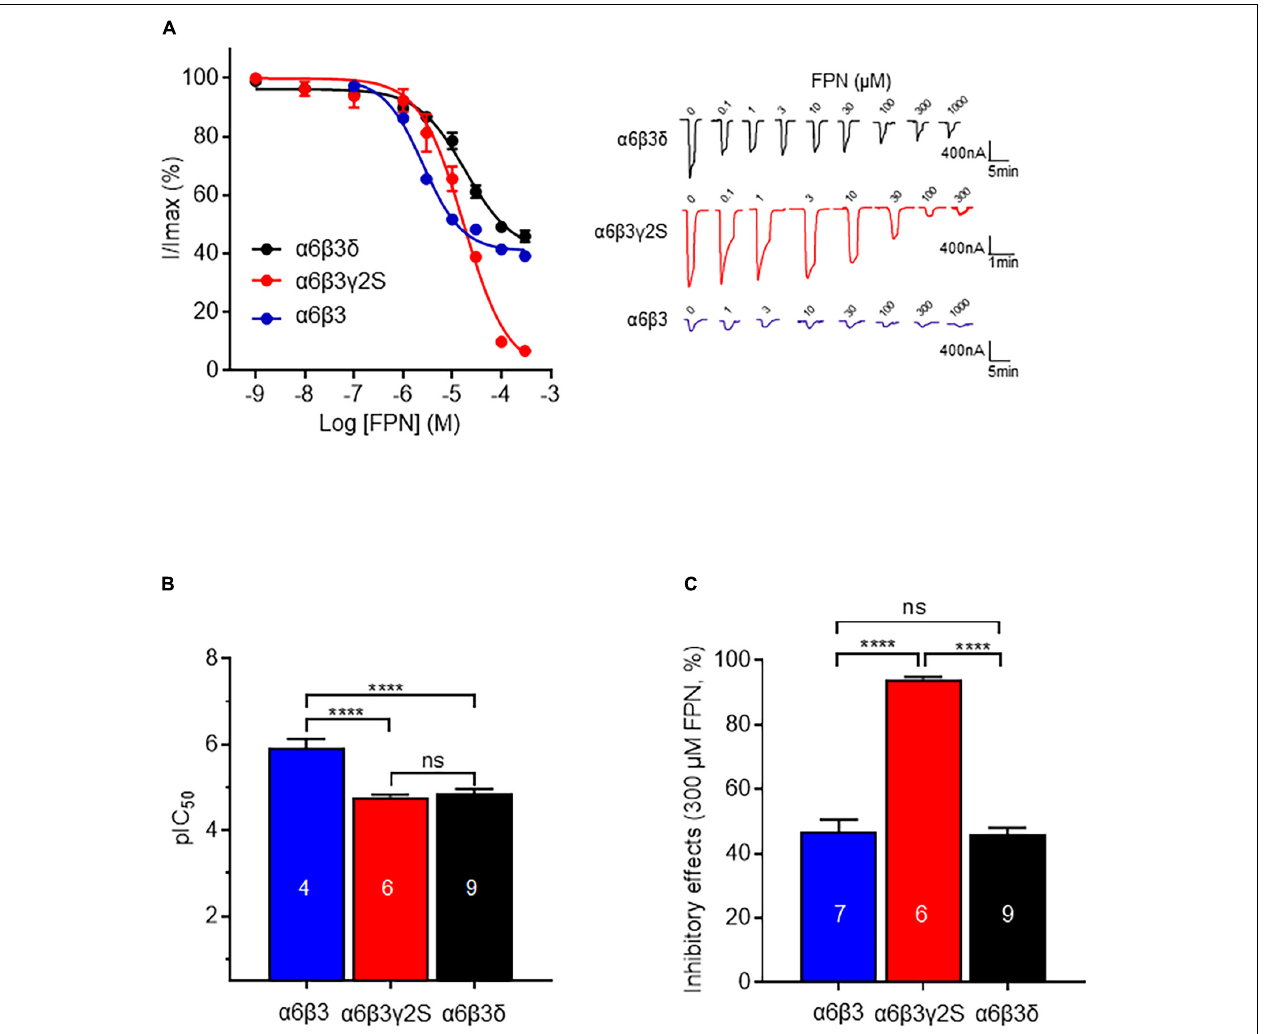
FIGURE 5 | Comparison of inhibitory effects of FPN on α 6 β 3 γ 2S, α 6 β 3 δ , and α 6 β 3 GABA A Rs. (A) Left: Concentration-inhibition curves of FPN on α 6 β 3 γ 2S, α 6 β 3 δ , and α 6 β 3 GABA A Rs stimulated with GABA (EC 50 ). Data were best fitted by non-linear regression to the Hill equation with variable slope. For α 6 β 3 γ 2S, pIC 50 was 4.86 ± 0.10 and Hill coefficient = 0.80 ± 0.05, R 2 = 0.96; for α 6 β 3 δ , pIC 50 was 4.78 ± 0.05 and Hill coefficient = 0.90 ± 0.12, R 2 = 0.93; for α 6 β 3, pIC 50 was 5.93 ± 0.20 and Hill coefficient = 1.08 ± 0.29, R 2 = 0.99. Right: Representative responses to concentration-inhibition of FPN on α 6 β 3 γ 2S, α 6 β 3 δ , and α 6 β 3 GABA A Rs stimulated with GABA (EC 50 ). (B,C) Analysis of the inhibitory effects of FPN on α 6 β 3 γ 2S, α 6 β 3 δ and α 6 β 3 GABA A Rs. Potency (pIC 50 , B ) and efficacy (maximum inhibition obtained with 300 µ M FPN, C ) of FPN on the three α 6-containing GABA A Rs were compared. Normality of data distribution was validated using Shapiro-Wilk test and data were analyzed with one-way ANOVA followed by multiple comparison test with Tukey test (ns: non-significant, **** p < 0.0001). Data are mean ± SEM of at least two independent experiments ( n = 4–9 cells) (see also Table 2 ). TABLE 2 | Fitting parameters of FPN inhibition on α 6 β 3, α 6 β 3 γ 2S, and α 6 β 3 δ GABA A Rs. IC 50 ( µ M, ± SEM) pIC 50 ± SEM Hill coefficient ± SEM Maximal inhibition (% ± SEM) n α 6 β